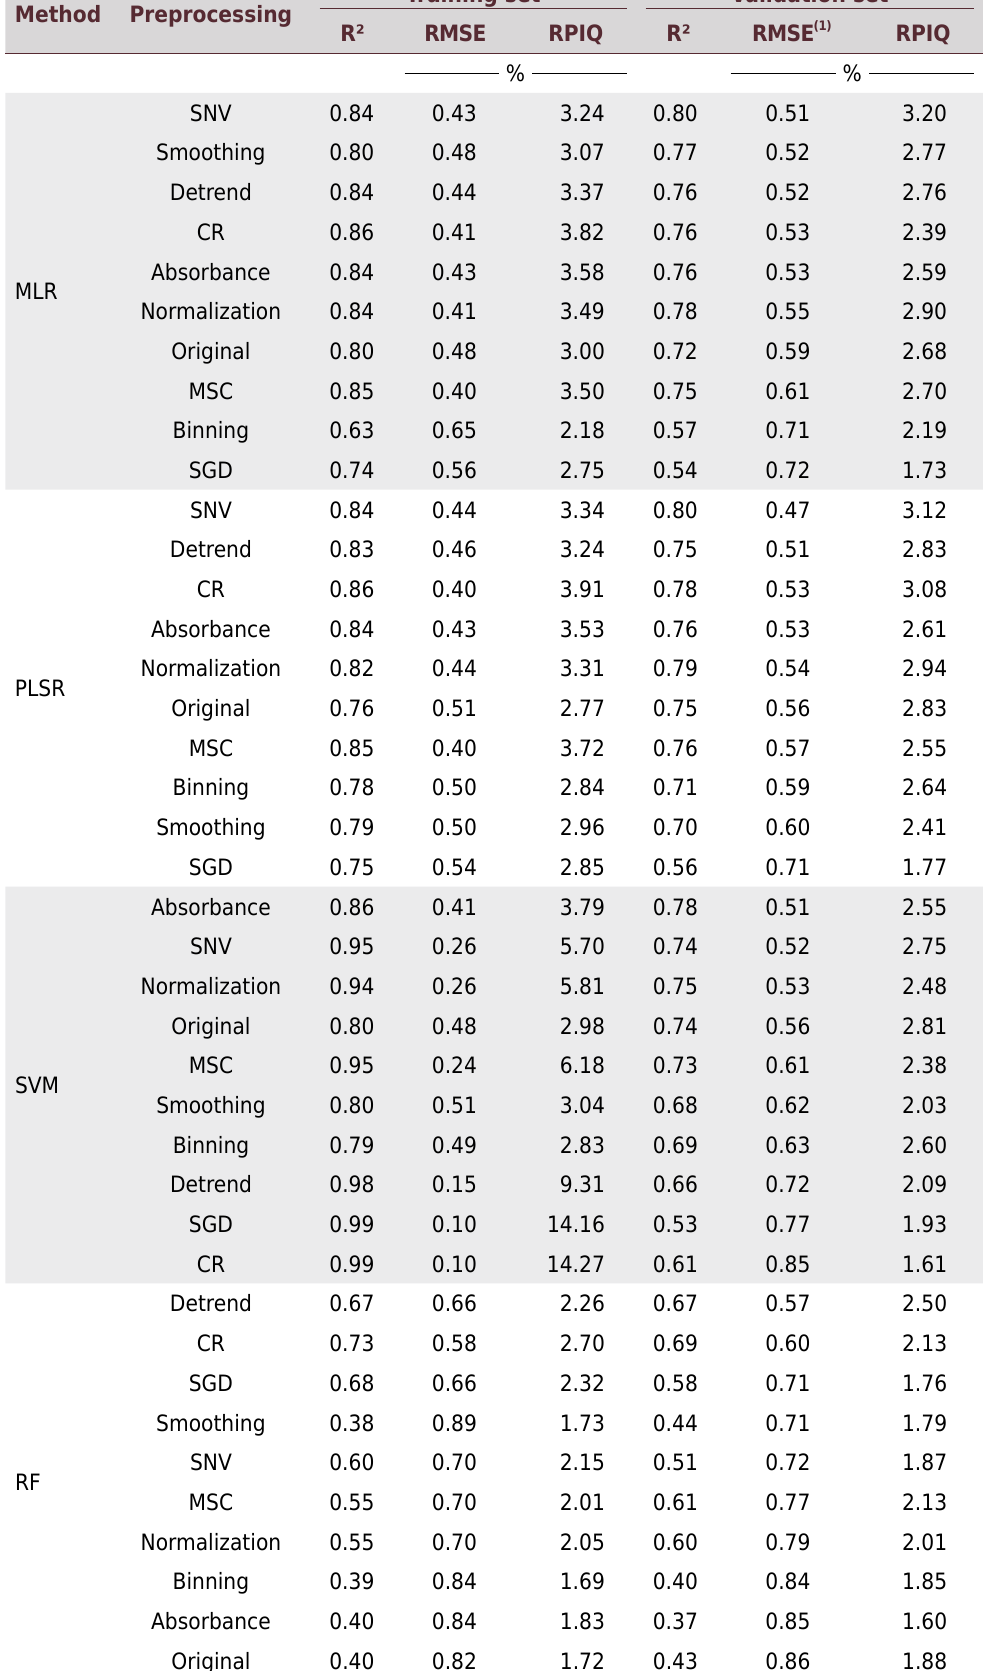
Table 4. The prediction statistics of SOC for each model